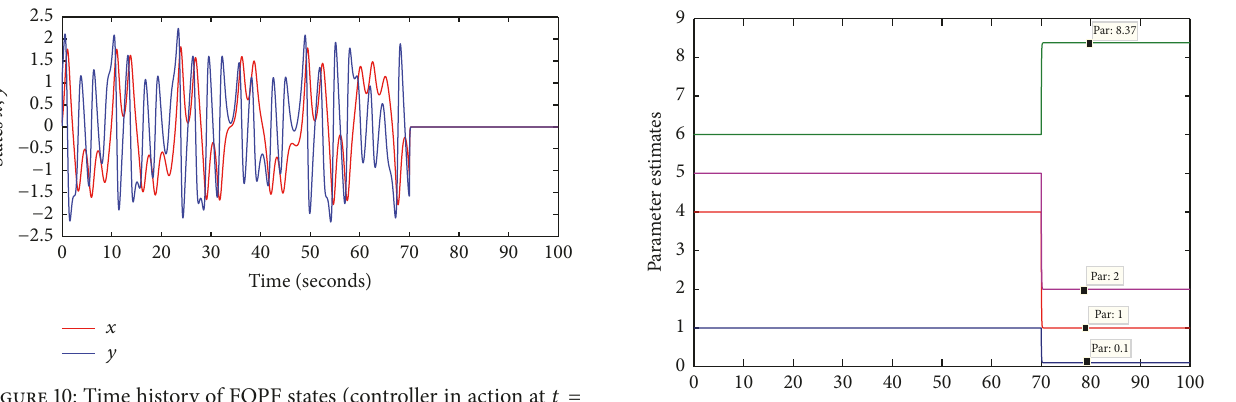
Figure 10: Time history of FOPF states (controller in action at 𝑡 = 70 s).